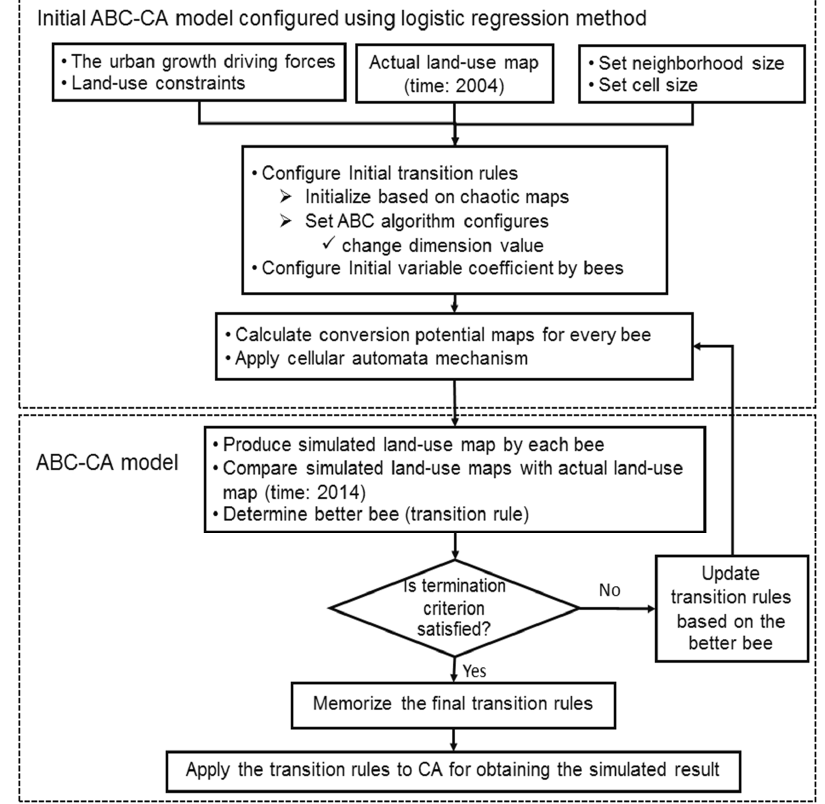
Figure 1. The proposed ABC-CA model. ABC, artificial bee colony; CA, cellular automata.